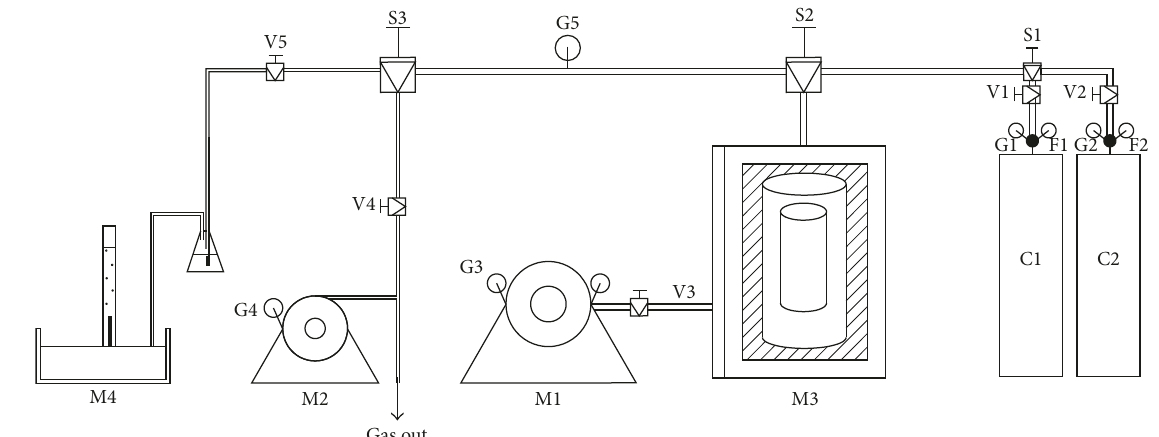
Figure 2: Schematic diagram of the experimental apparatus used in this study. C1 and C2: methane (CH 4 ) and helium (He) cylinder storage; F1 and F2: flow of gas; G1, G2, and G3: gauge for displaying the pressure of methane, helium, and water, respectively; G4: negative gauge for air pressure used for vacuum; G5: gauge for sample gas pressure; V1, V2, V3, V4, and V5: needle valves; S1, S2, and S3: three-port valves; M1: water injection pump; M2: vacuum pump; M3: temperature-controlling device; M4: measurement